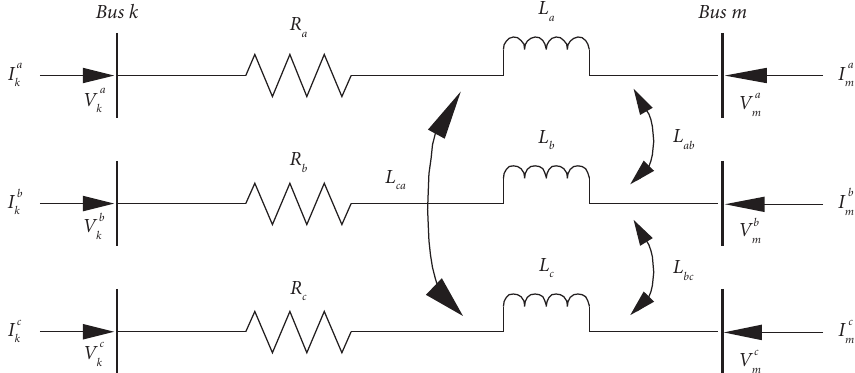
Figure 8: Tree-phase power fow model for a transmission line connected between two buses. Where R a,b, and c ; L L L � self-inductance of phases a,b, and c ; L a , b , and c V b V c � bus voltage of phases a, b, and c at bus k ; V a c , and phases c and a ; V a k , k , and k I a I b I c � current of phases a,b, and c injected at bus k ; I a k , k , and k